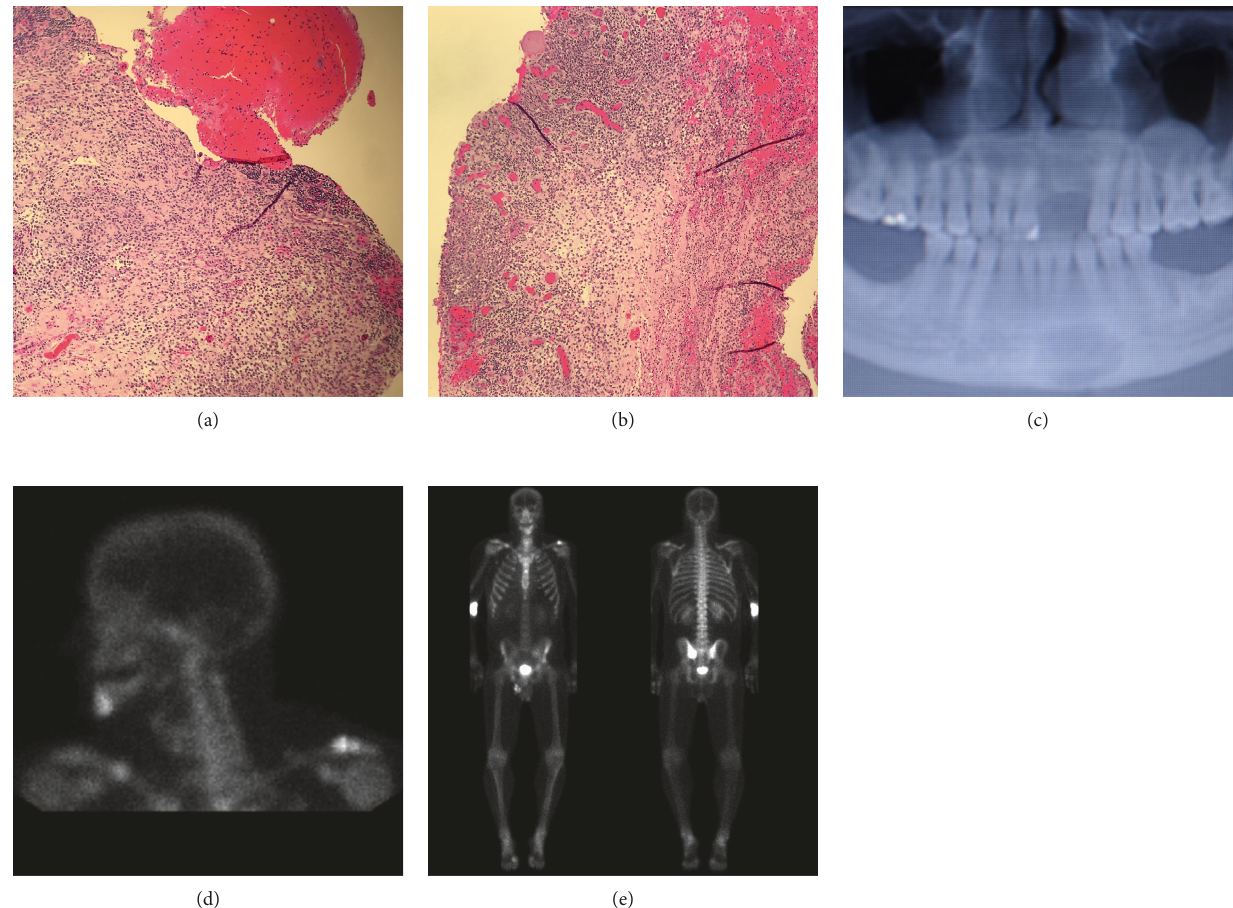
Figure 1: Histology of left iliac bone biopsy (a-b), X-ray of the mandible with lytic lesion (c), and bone scintigraphy images